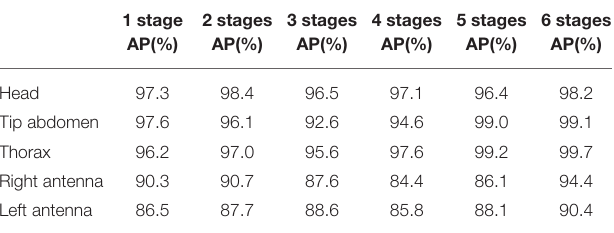
TABLE 2 | Body part detection Performance (mAP) per number of stages.